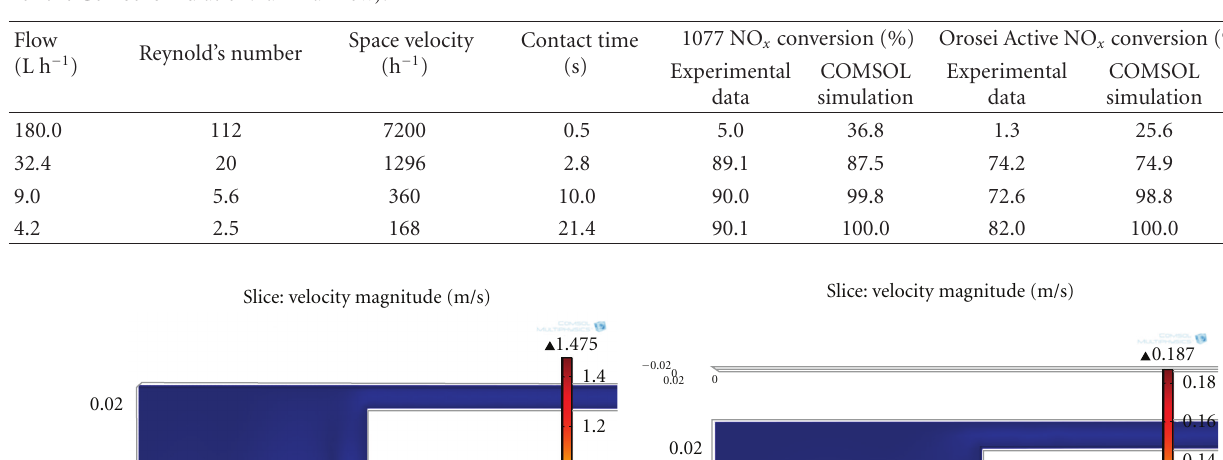
Table 1: Data from continuous reactor and Comsol simulations (NO x 500 ppb, 20Wm -2 , sample size 0.005 cm 2 , RH: 40%, run time: 3 h. For the Comsol simulation: laminar flow).